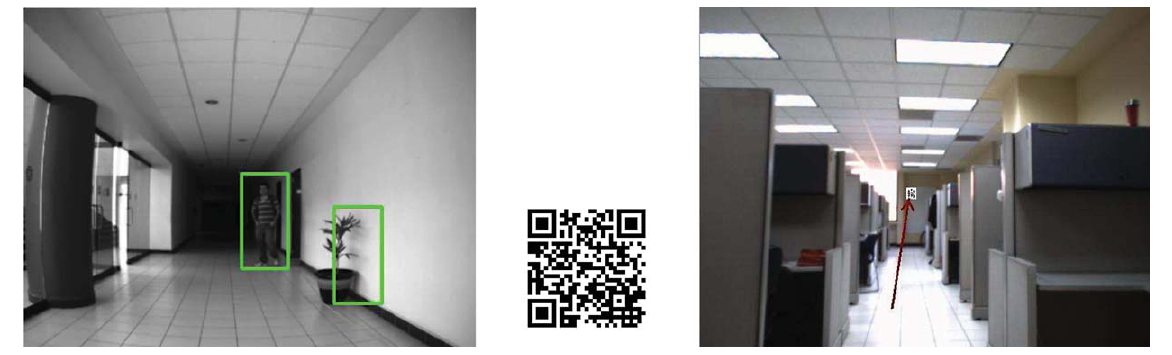
Fig. 11. Detection of arbitrary contours based on HOG and a SVM classifier. (a) (left) A person and a plant are detected; b) a QR-image (c) (right) a QR-announce.